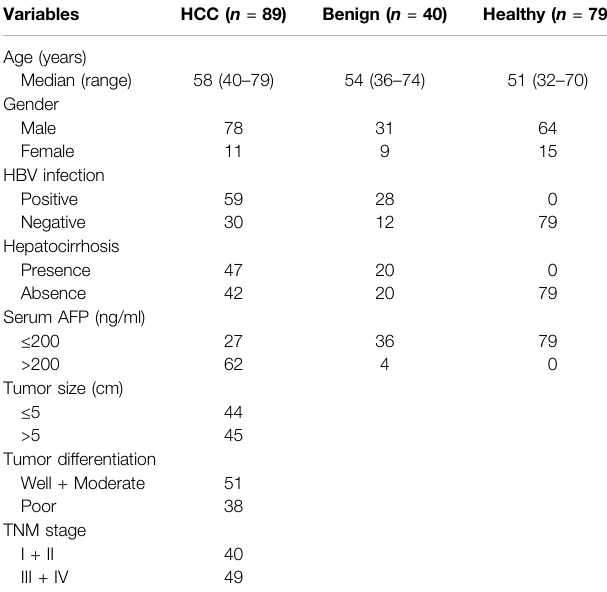
TABLE 1 | Demographic and clinical characterization of study